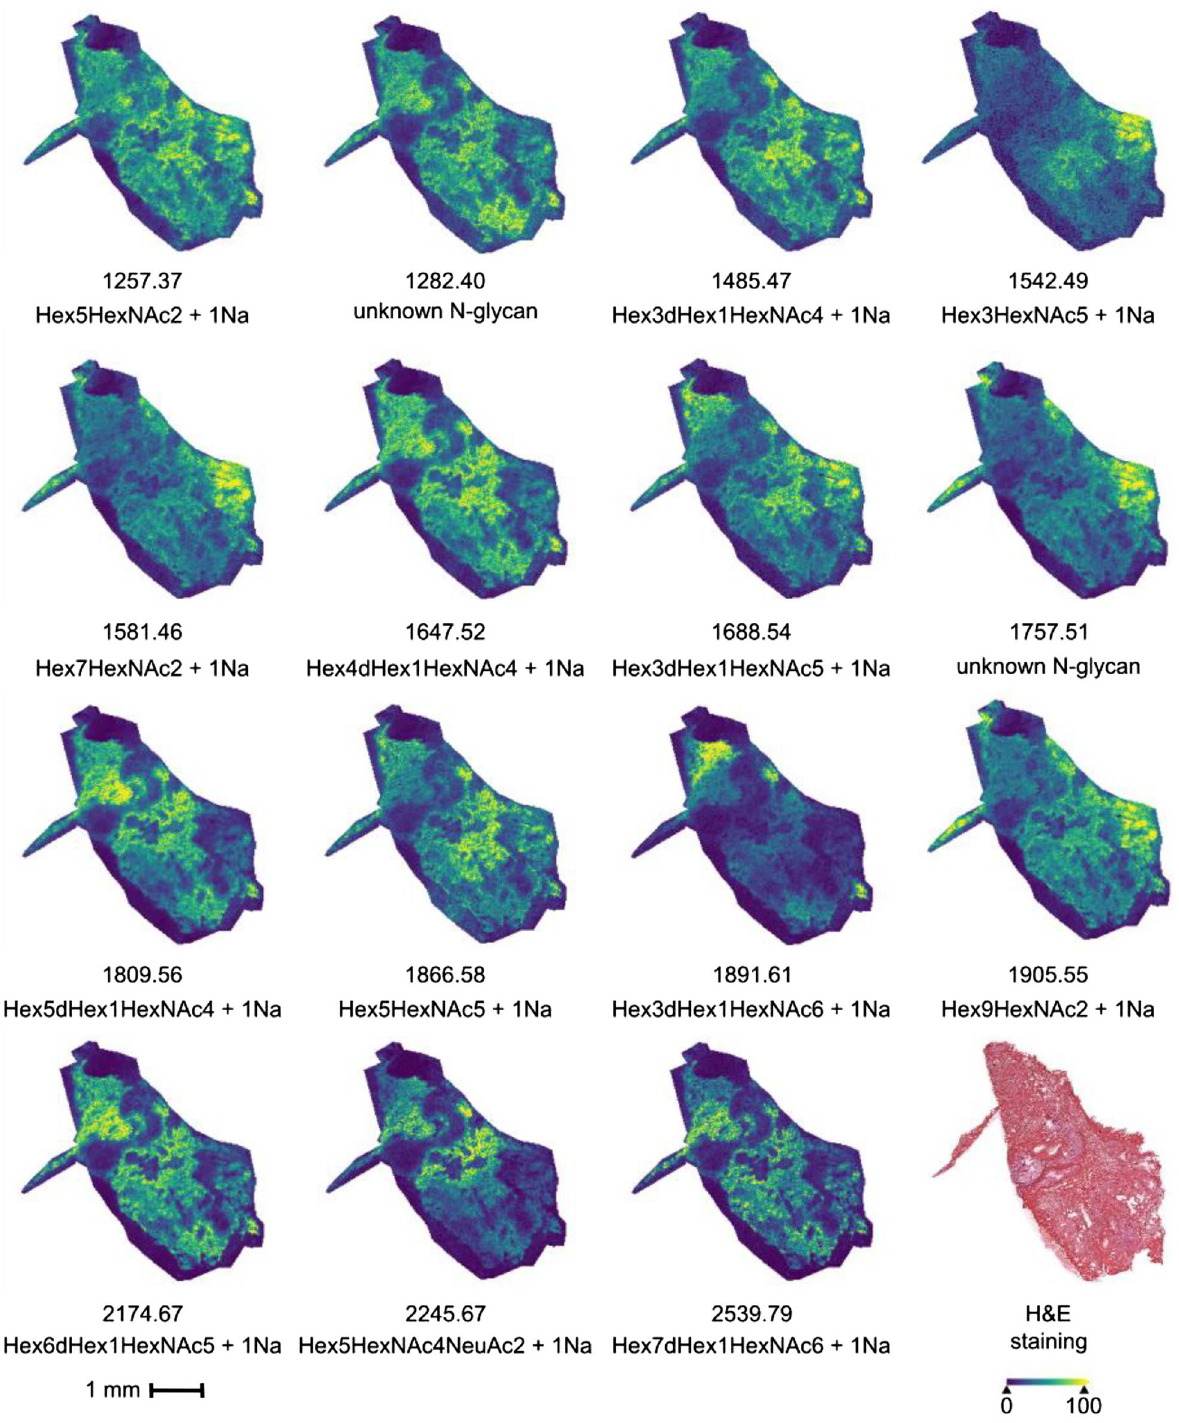
Figure 2. MALDI MSI images of selected potential N-glycans in fresh frozen CCA tissue. The spatial distribution of 15 potential N-glycan m/z -values detected in the same tissue section is highlighted. Tentative identification were provided where possible. Measurement was done in positive ion-mode and with a pixel size of 16 × 16